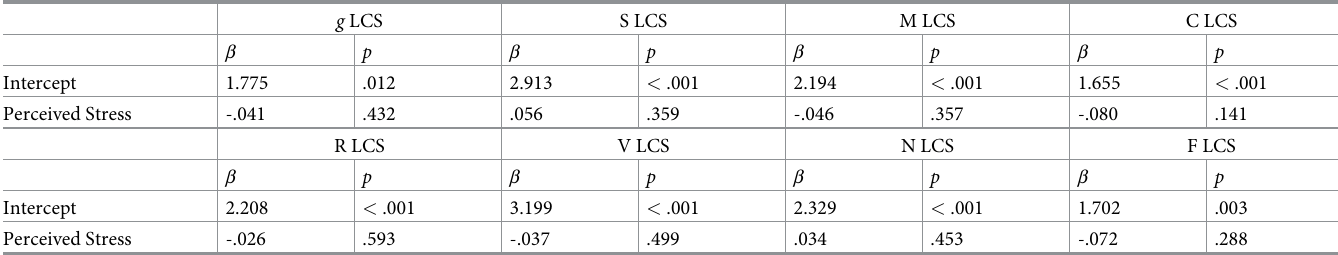
Table 8. Standardized parameters of the latent change score structural equation models in Study